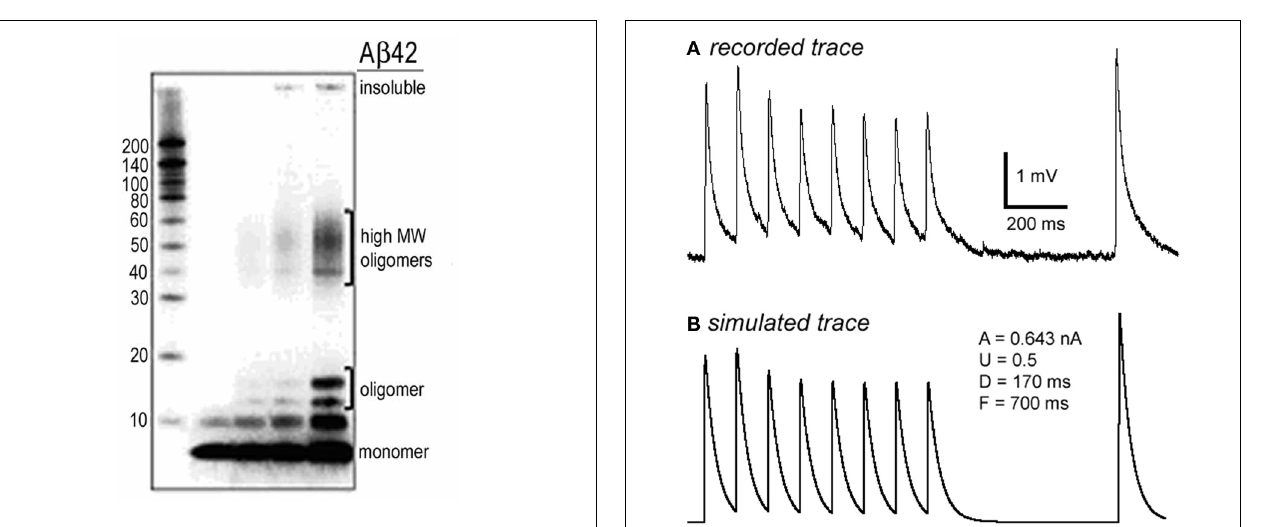
FIGURE A2 | Computer simulation of synaptic responses. The 10Hz EPSP train followed by a RTR with 500ms delay was recorded from a PC-IN connection (A) . Using a model of dynamic synaptic transmission, the synaptic dynamics were assessed by fitting the EPSPs (B) . The modeling extracts four key parameters of the connection: DFUA ( D , the time constant of recovery from depression; F , the time constant of recovery from facilitation; U , utilization of synaptic resources used analogously to release probability, p ; A , the absolute synaptic strength). If samplings were big enough, these parameters could be quantitatively analyzed enabling a quantitative comparison of basal synaptic dynamic